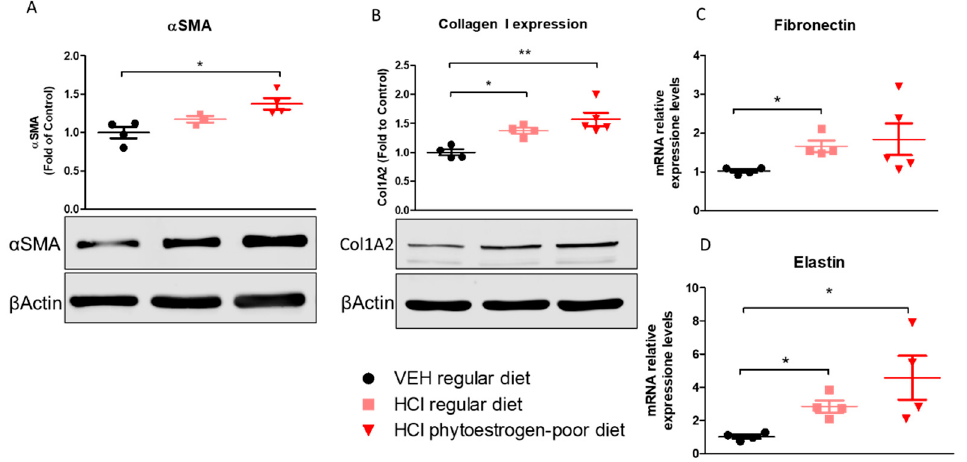
Figure 6. Extracellular matrix protein or mRNA expression in lung tissue. α -Smooth Muscle Actine ( A ), Collagen Type I ( B ), Fibronectin ( C ) and Elastin ( D ) were overexpressed in mice on phytoestrogen-poor diet. Means ± SEM; **: p < 0.01, *: p < 0.05 with one-way ANOVA and Tukey’s, n = 45; VEH: